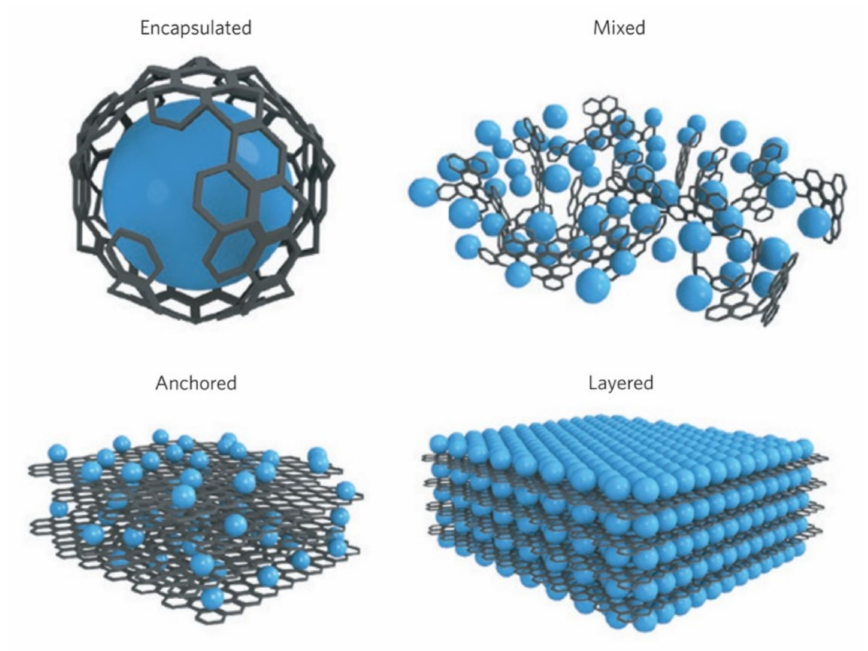
Figure 2. Schematic drawings of graphene composite materials with various structures. Reproduced with permission from ref. [16]. Copyright 2015,